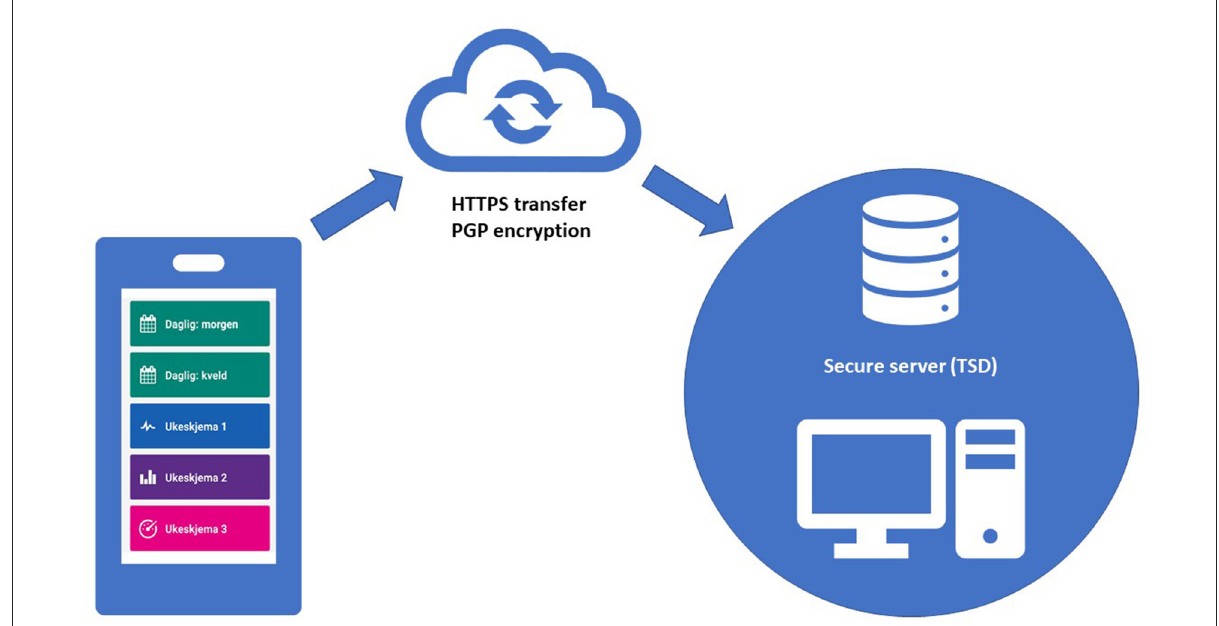
FIGURE1 Technical structure for data collection.